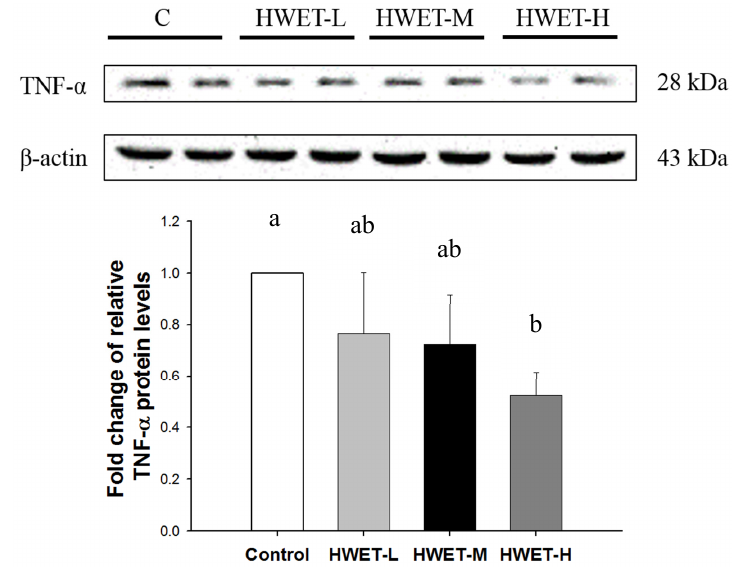
Figure 6. Effects of HWET treatment on TNF- α expression in liver of mice after swimming endurance test. Mice were treated with vehicle (control), 800 mg/kg (HWET-L), 1600 mg/kg (HWET-M), or 4000 mg/kg (HWET-H) of HWET once per day for 7 days; all mice were euthanized and analyzed for TNF- α expression in liver tissue 1 h after swimming endurance test. Values are expressed as the mean ± SEM. Different letters indicate statistical difference, p < 0.05.